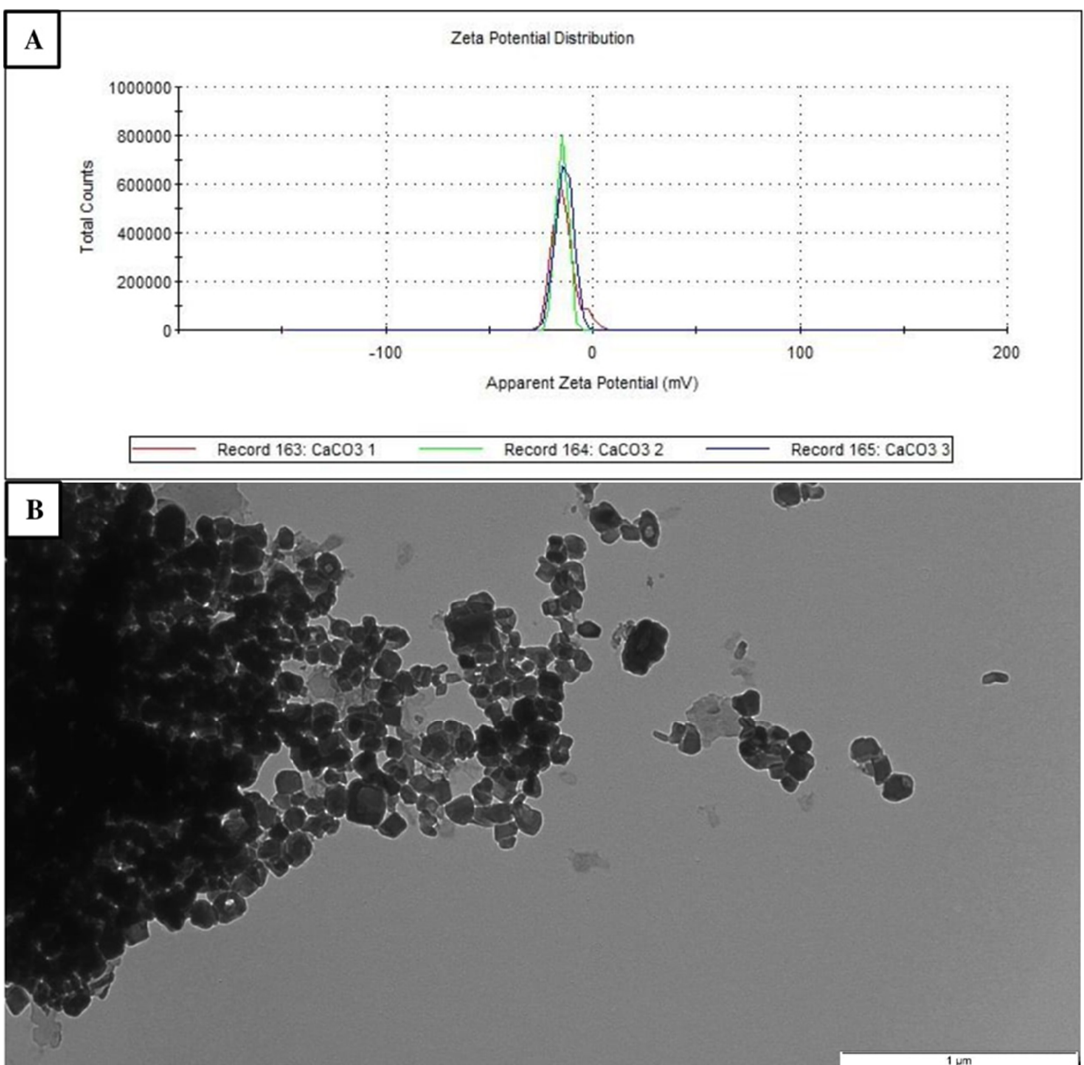
Figure 1. Representative zeta potential of CCN at the concentration of 50 μ g/mL (three peaks) ( A ). Transmission electron microscope image of CCN. Scale bar represents 1 μ m ( B ).